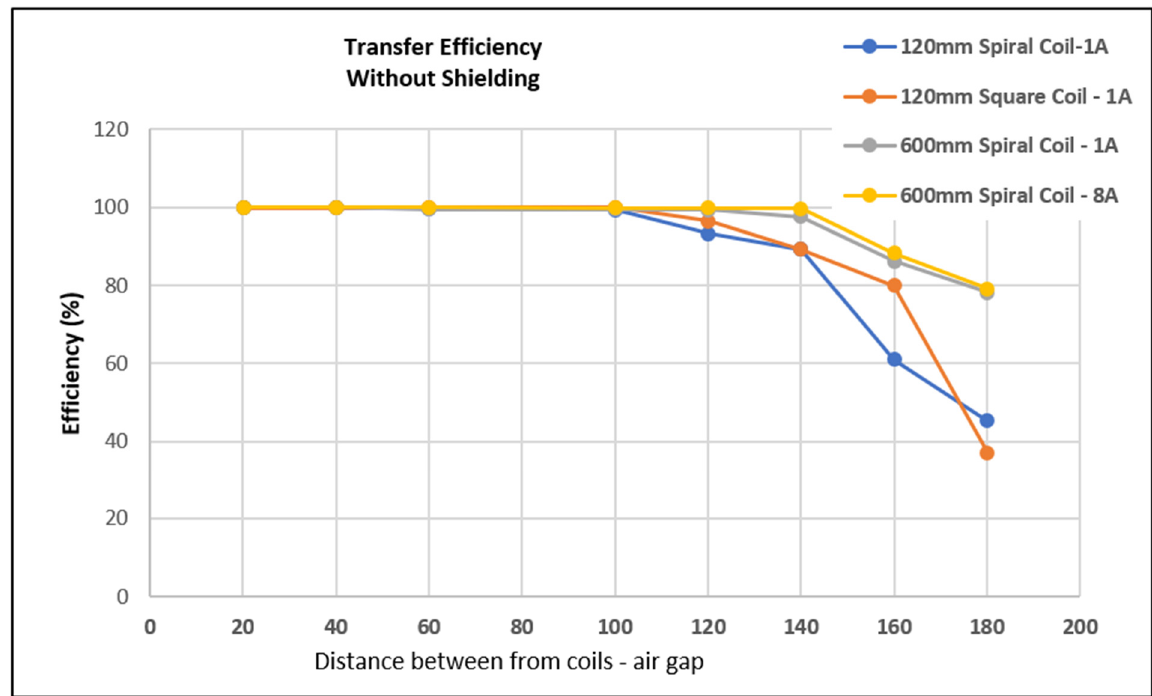
Figure 6. Transmission efficiency across multiple air gap values for different coil designs.